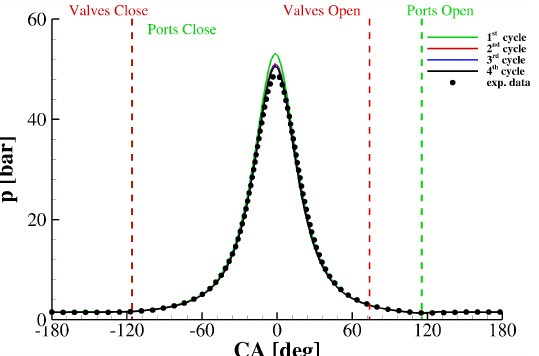
Figure 9. In-chamber pressure as a function of CA. Comparison between numerical results and